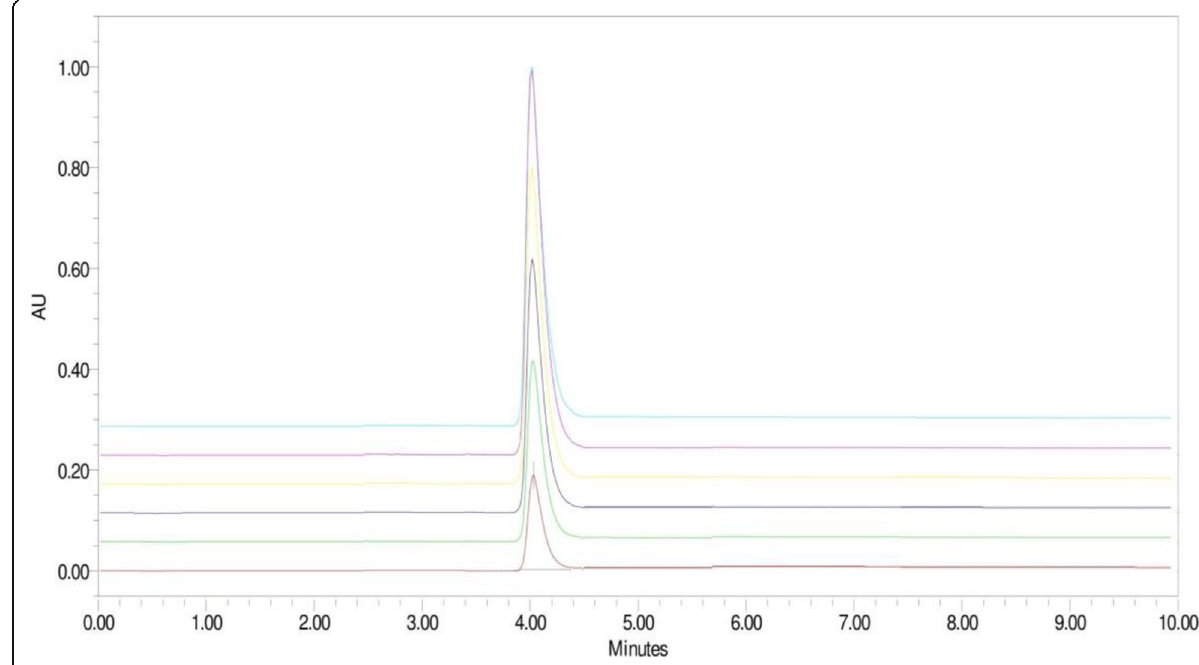
Fig. 5 Linearity of 10 – 200 μ g/ml ceftriaxone